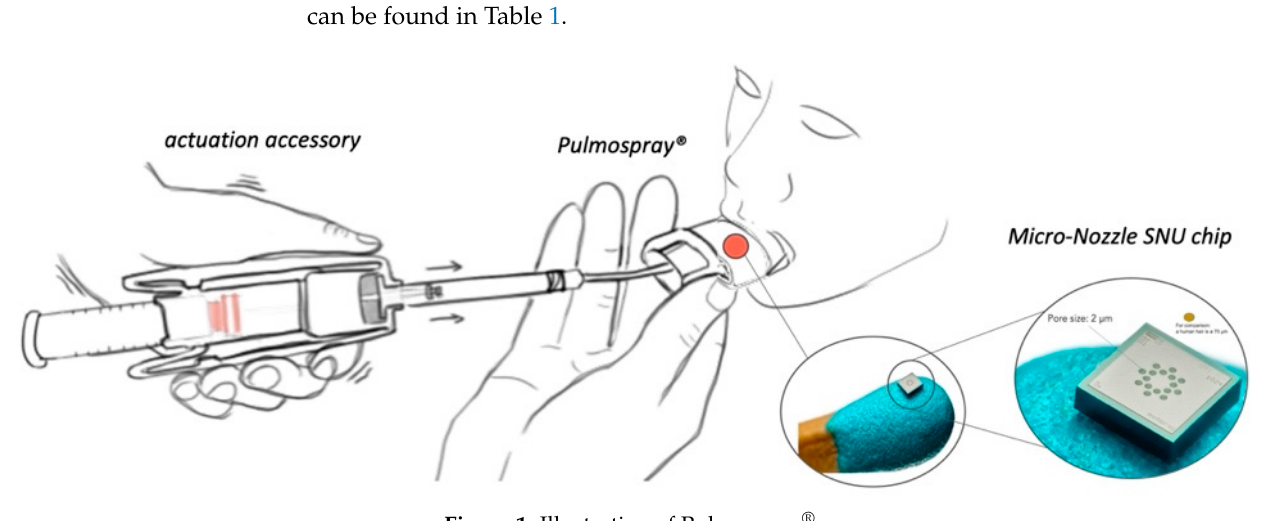
Figure 1. Illustration of Pulmospray ® . Table 1. Inclusion and Exclusion Criteria for All